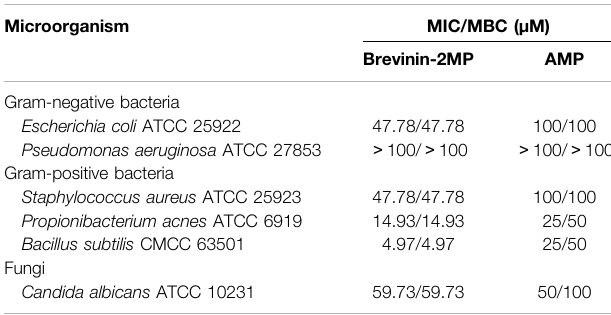
TABLE 1 | Antimicrobial activity of